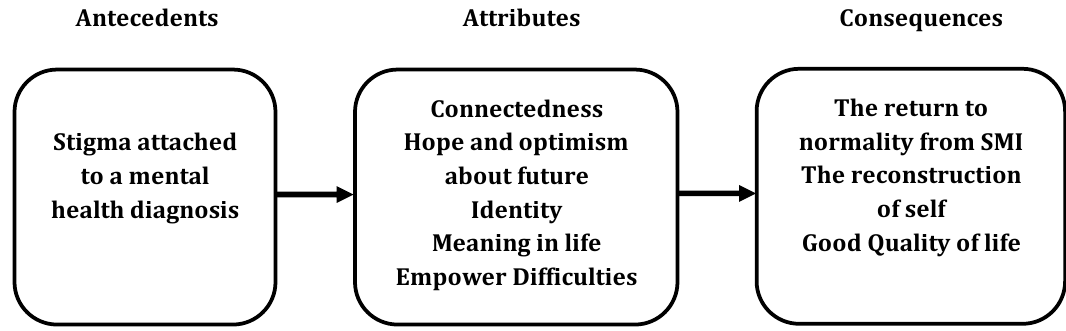
Fig. 1. Model of Personal Recovery of